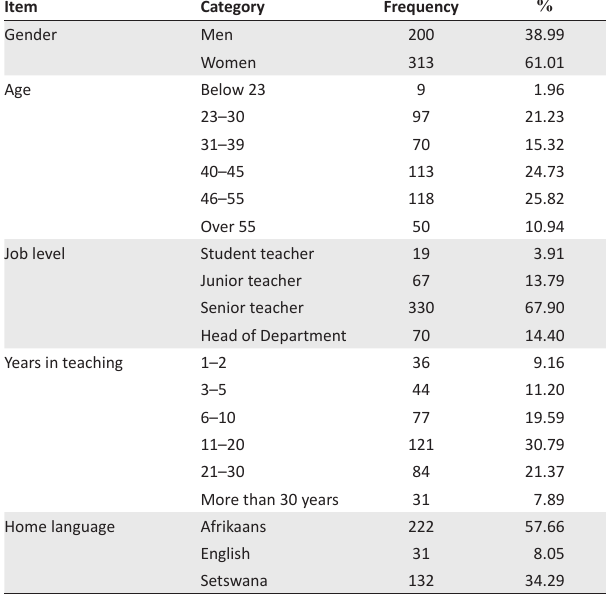
TABLE 1: Characteristics of participants ( N =